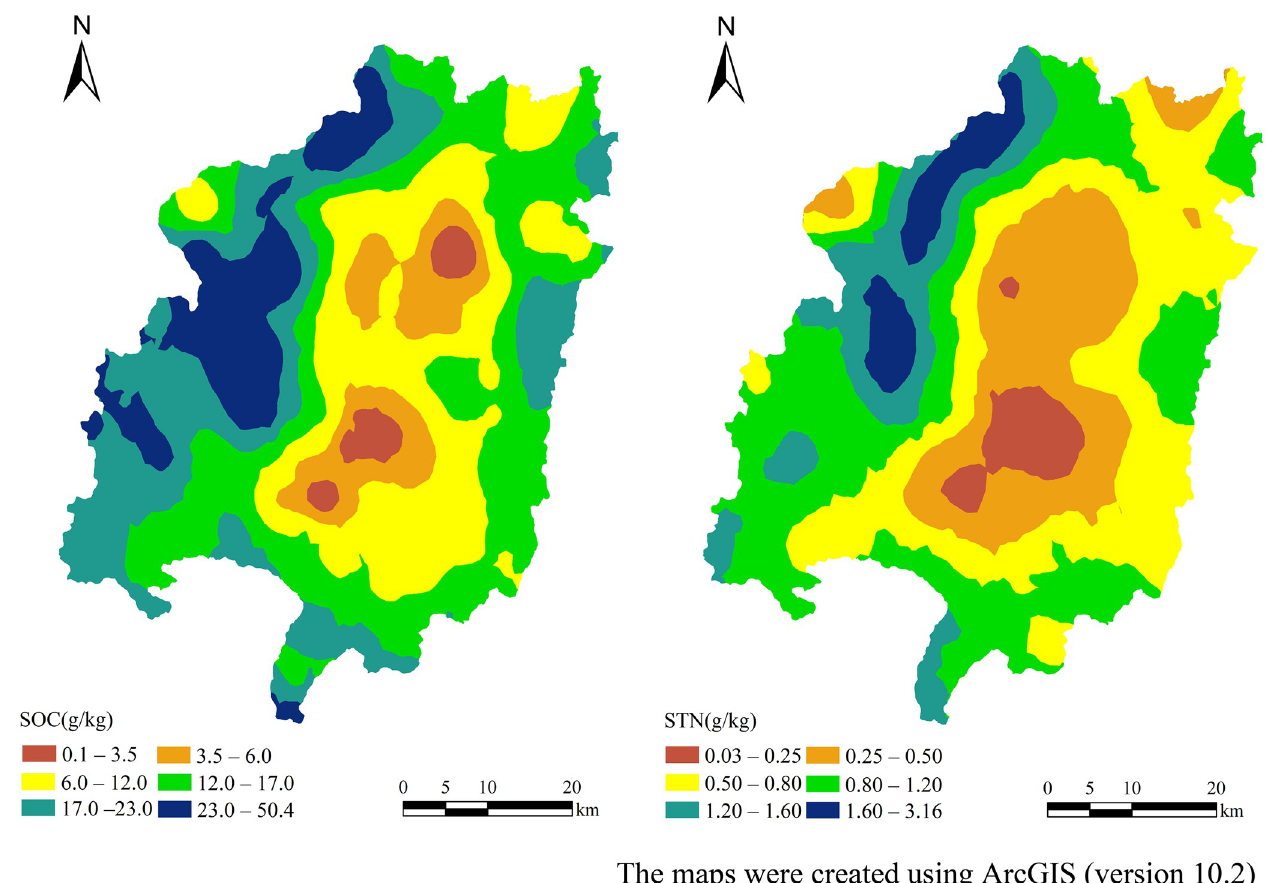
Fig 4. Spatial distribution maps of SOC and